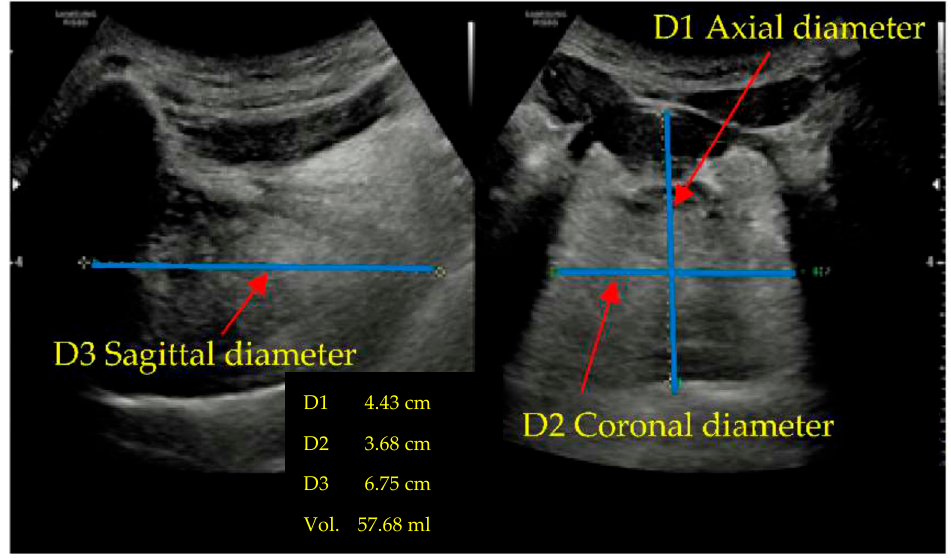
Figure 1. US image of the tongue in grayscale mode B. The axial, sagittal diameters and volume are visualised (i.e., D1 axial, D2 coronal and D3 sagittal diameters; taken from our data).